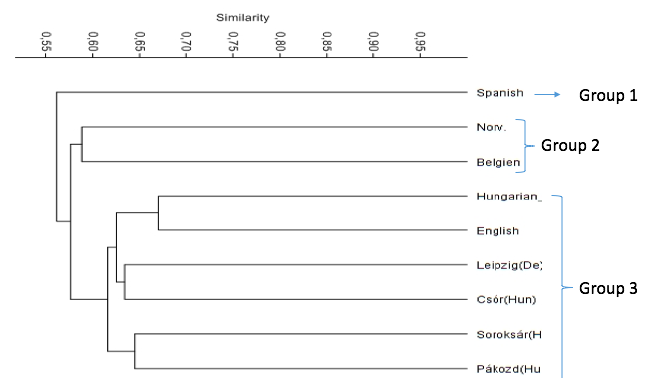
Fig. 3: Dendrogram showing the relationship among the studied A. ab- sinthium accessions (Generated by combination of RAPD and ISSR primers using UPGMA